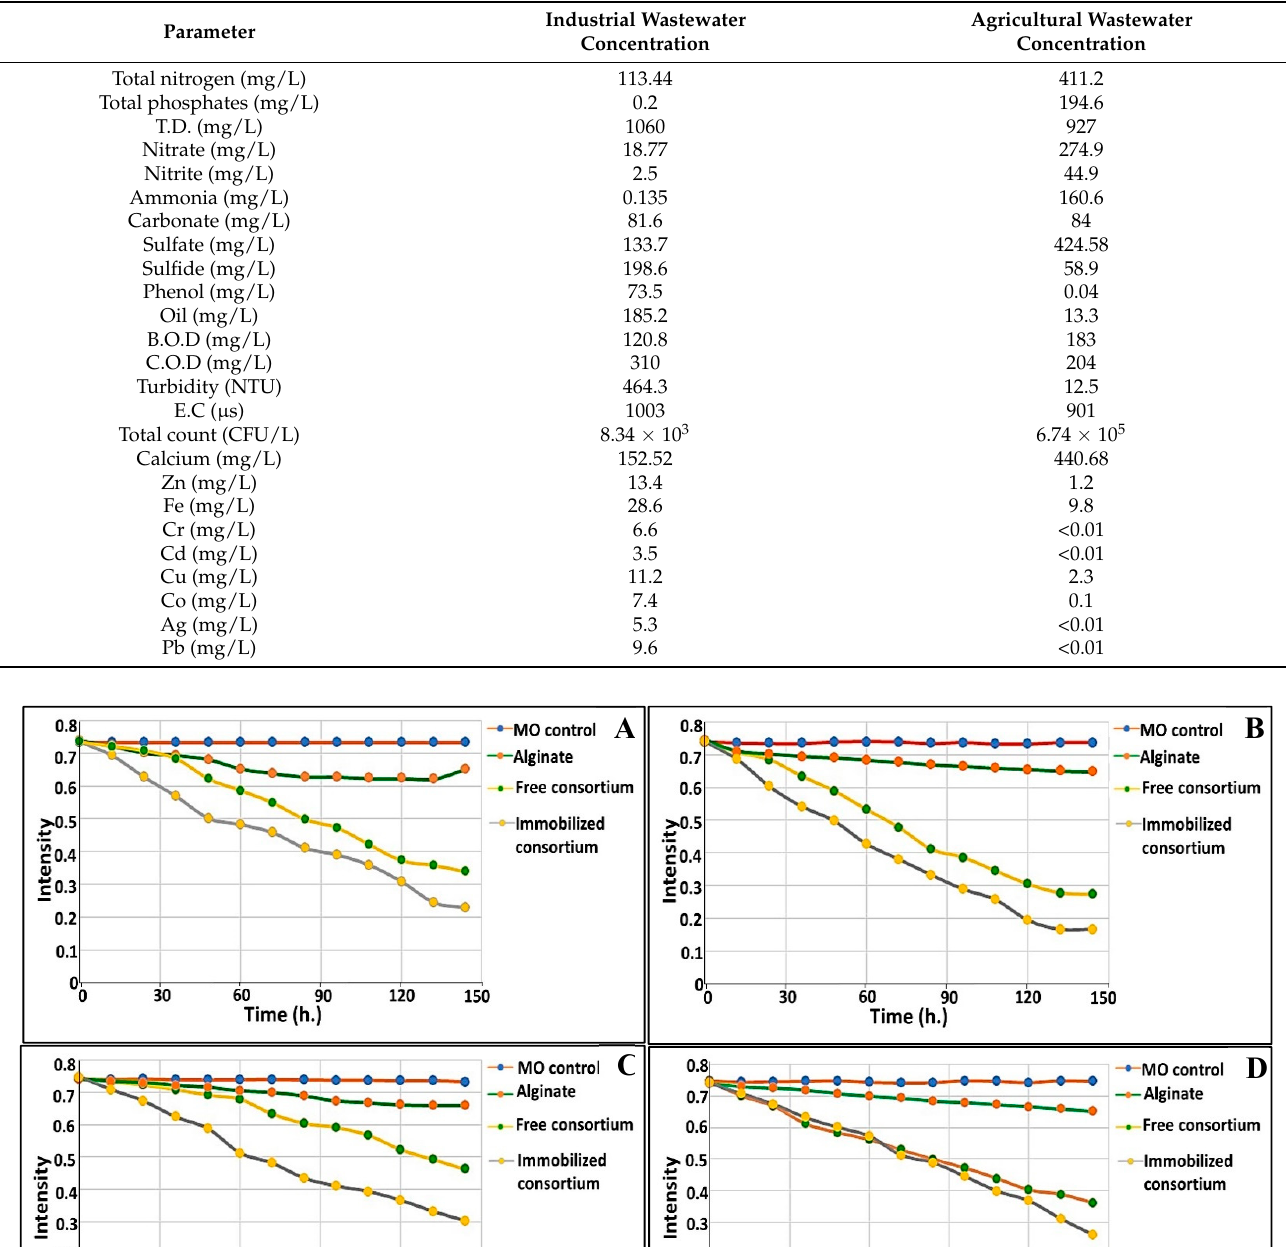
Table 5. Quality analysis of agricultural and industrial effluents.